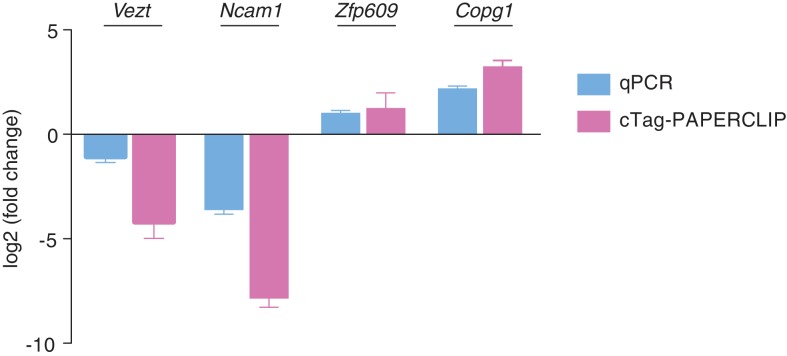
qPCR validation of 3’UTR isoform abundance differences between Purkinje and granule cells.N = 3 for each time point for qPCR. N = 4 for cTag-PAPERCLIP on granule cells and N = 3 for cTag-PAPERCLIP on Purkinje cells. Log2(fold change) represents log2 of the ratio between the ratios of distal 3’UTR isoform abundance over total mRNA abundance in Purkinje vs. granule cells for 3’UTR-APA genes (Vezt and Ncam1). For CDS-APA genes (Zfp609 and Copg1) the log2(fold change) represents log2 of the ratio between the ratios of distal 3’UTR isoform abundance over proximal 3’UTR isoform abundance in Purkinje vs. granule cells.